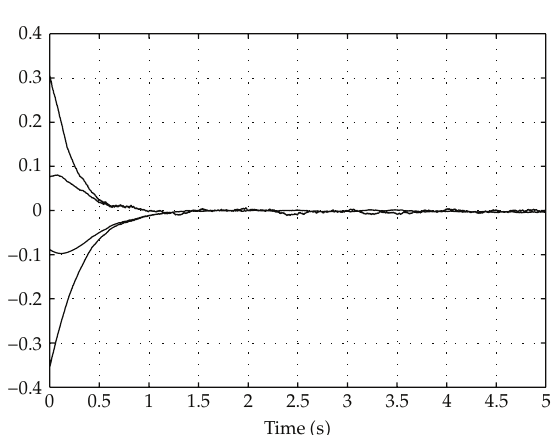
Figure 1: State trajectories.